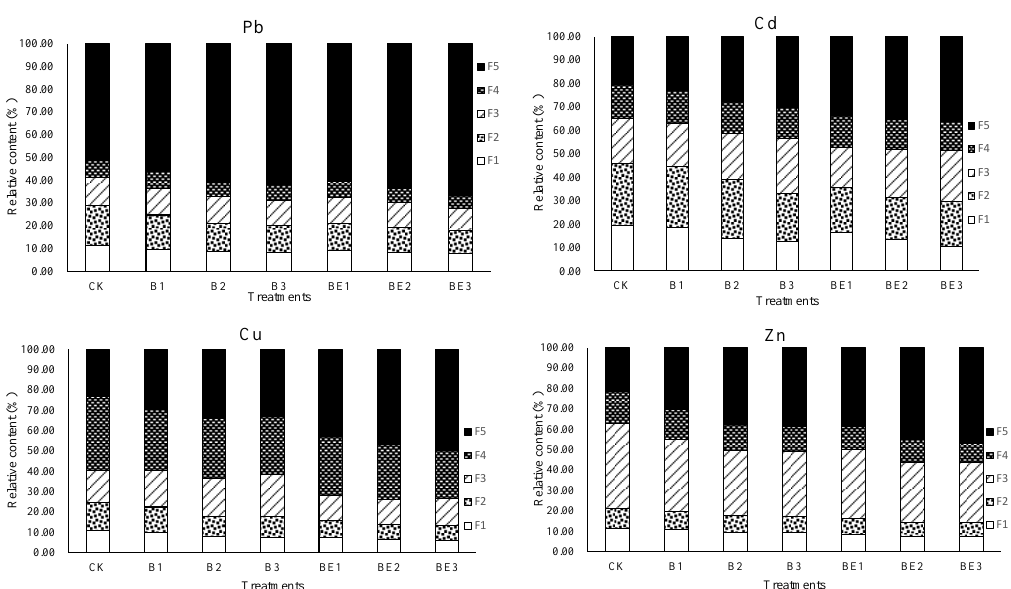
Figure 5. Fractionation of heavy metals in industrial sludge for different treatments. Heavy metal fractions are F1 (exchangeable), F2 (carbonate-bound), F3 (Fe–Mn oxides), F4 (organically bound) and F5 (residual).